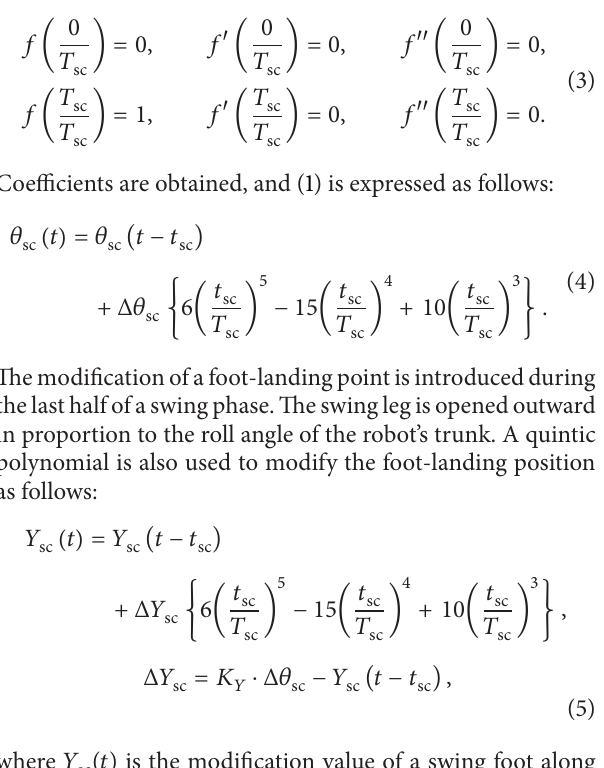
Figure 5: Block diagram of the foot placement modification control. 𝑋 , 𝜃 𝑦 , and 𝜃 𝑧 are preset foot orientations about the roll, pitch, and yaw axes, respectively. 𝜃 𝑥 is the roll attitude angle, and respectively. 𝜃 𝑥 fpat fpat fpat 𝑀 𝑀 𝑧 , roll, and pitch 𝐹 𝑧 , 𝑥 , and 𝑦 are ground reaction forces in the